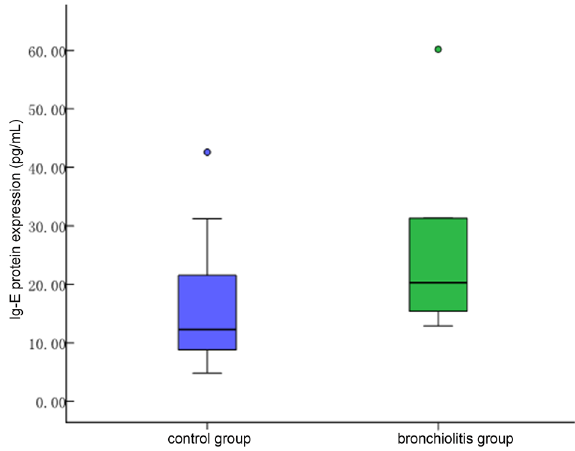
Figure 3. Ig-E protein levels of peripheral blood in control group and bronchiolitis group. There was no significance between two groups ( P > 0.05).